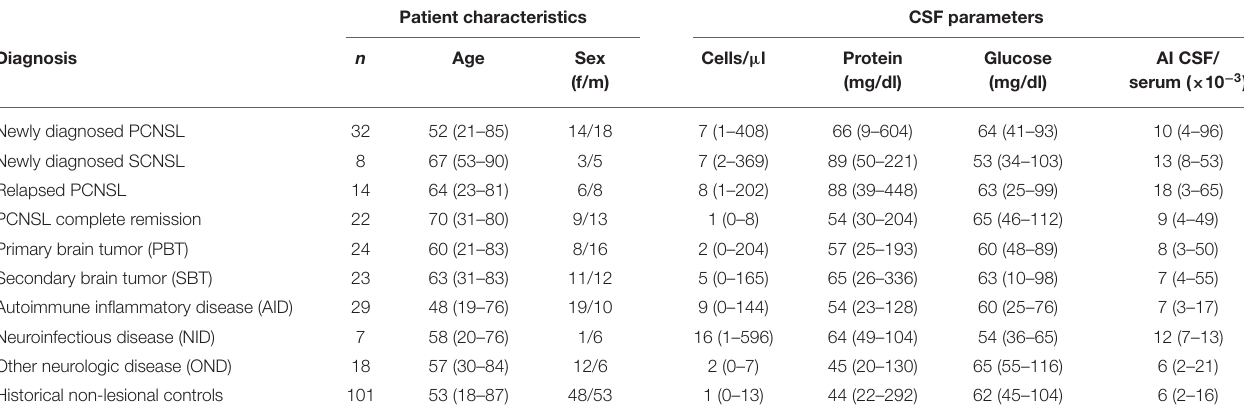
TABLE 1 | Patient characteristics and cerebrospinal fluid (CSF) parameters for the different patient